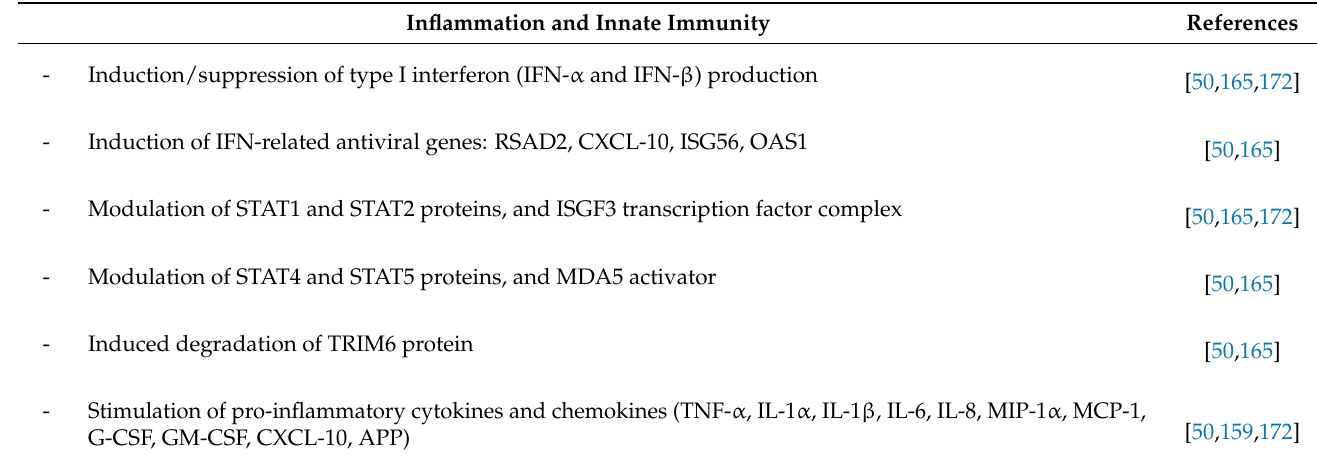
Table 2. Main features of innate immune modulation upon NiV infection. Inflammation and Innate